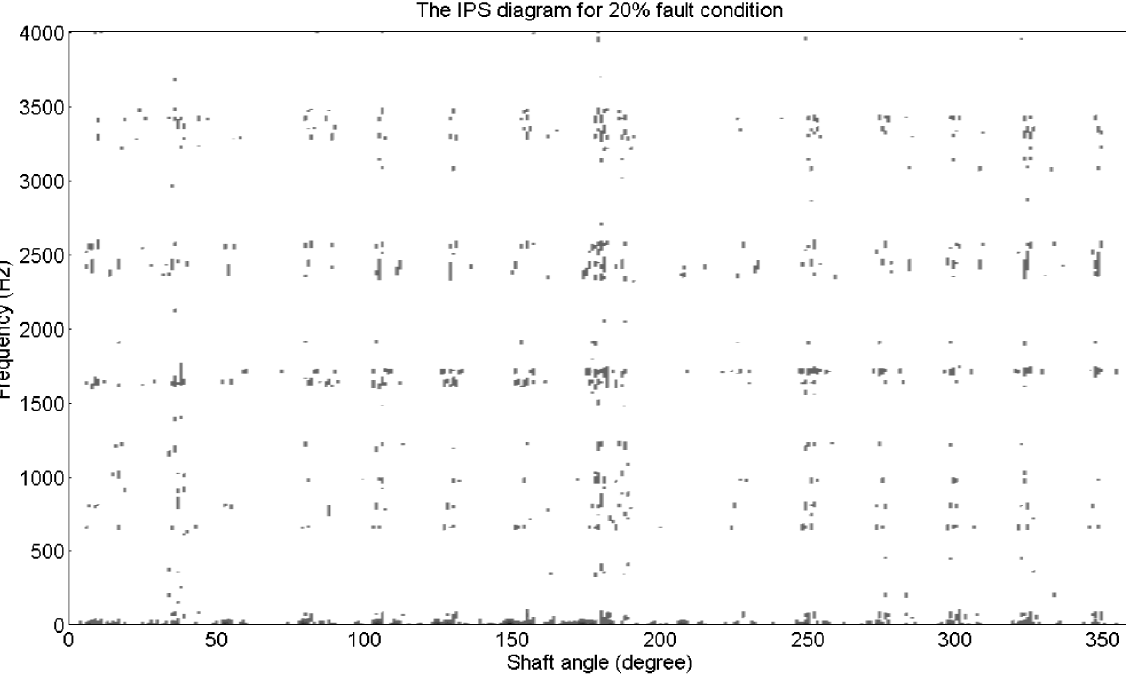
Fig. 8. IPS diagram for 20% fault